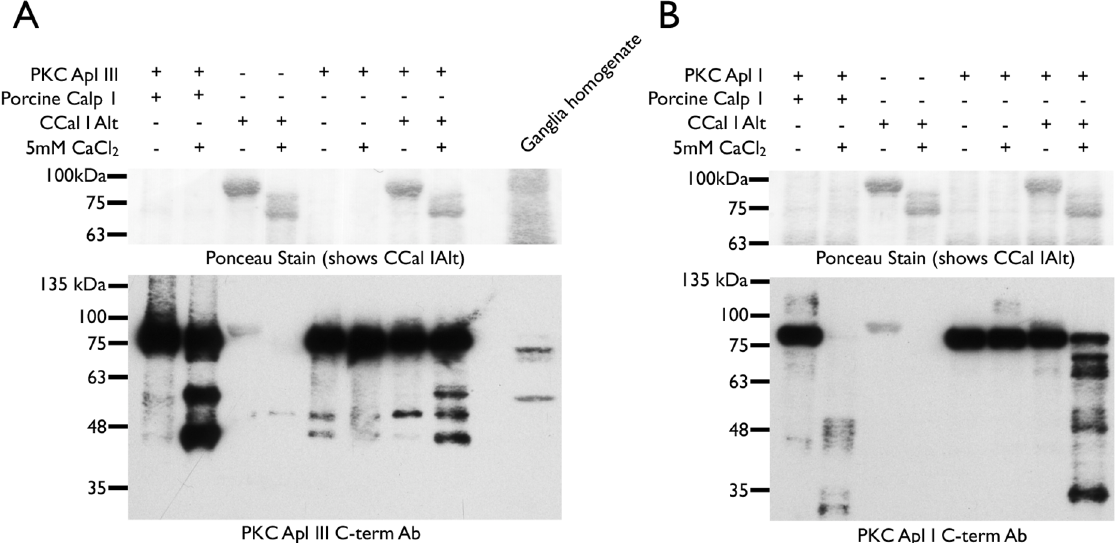
of Ca 2+ . AplCCal1alt aloneand PKC Apl III alonecontrols were also included. After incubation, 17ul sampleswere run alongside Aplysia gangliahomogenateon SDS-PAGE gel, transferred to nitrocellulose membrane,ponceaustained and probedwith a PKC Apl III C-terminalantibody. Similarcleavagewas observedin three independent experiments for AplCCal1b, one for AplCCal1a and two for AplCCal1alt (B) Porcinecalp-1 (85ng/ul)or Aplysia AplCCal1alt (855ng/ul) were incubated with PKC Apl I (550ng/ul) at room temperature for 1h (porcinecalp-1)or 3h ( Aplysia AplCCal1alt) in the presenceor absenceof Ca 2+ . AplCCal1alt aloneand PKC Apl I alone controlswere also included.After incubation,17ul samples were subjectedto SDS-PAGE, transferred to nitrocellulose membrane,ponceau stained and probed with an antibody directed against the PKC Apl I C-terminus. Similar cleavagewas observed in three independent experiments with AplCCal1alt and one with AplCCal1b.